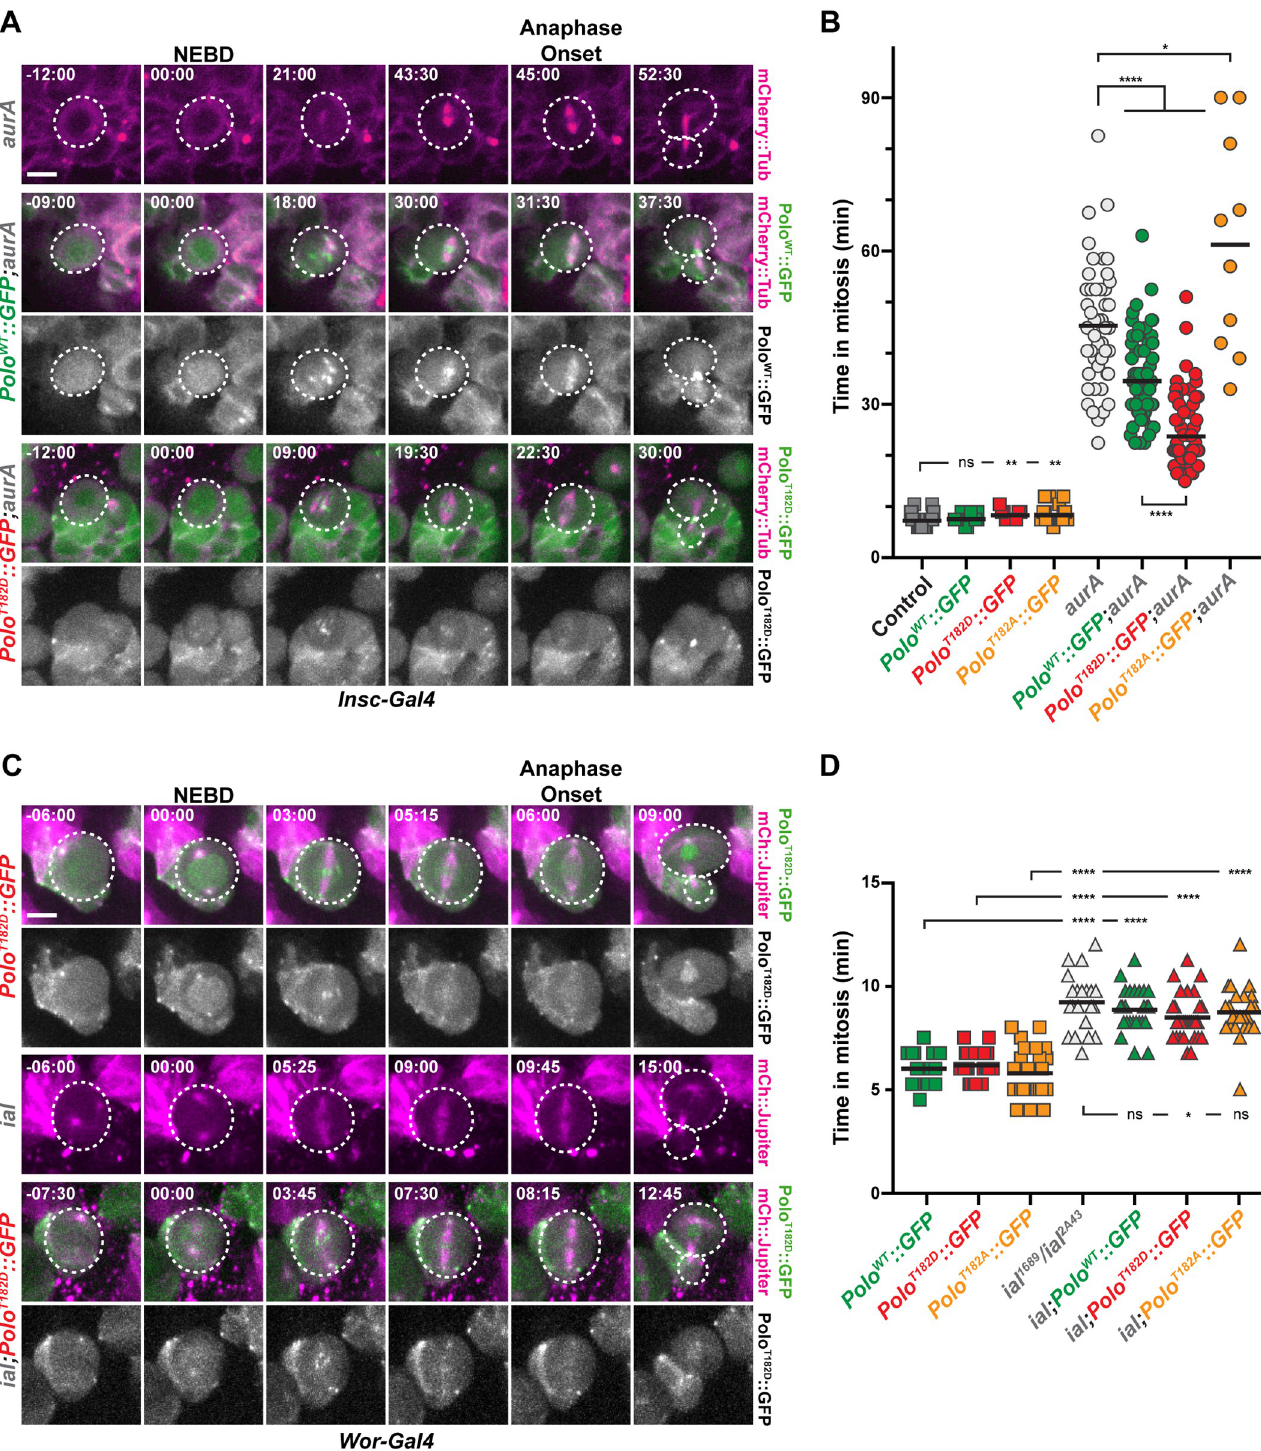
Fig 3. Mitotic delays in aurA and aurB mutants are Polo-dependent. A, C) Time-lapse imaging of mitosis in aurA (A) and aurB/ial (B) mutant NSCs expressing the indicated Polo variants and mCherry::Tubulin. The white dashed lines outline the dividing NSCs. Scale bar: 5 μ m. Time is min:s (t = 00:00 is NEBD). B, D) Quantification of time in mitosis for the indicated genotypes. Means are shown as black bars. Mann-Whitney unpaired tests: ns: p > 0.05; � : p < 0.05; �� : p < 0.01; ���� : p < 0.0001.